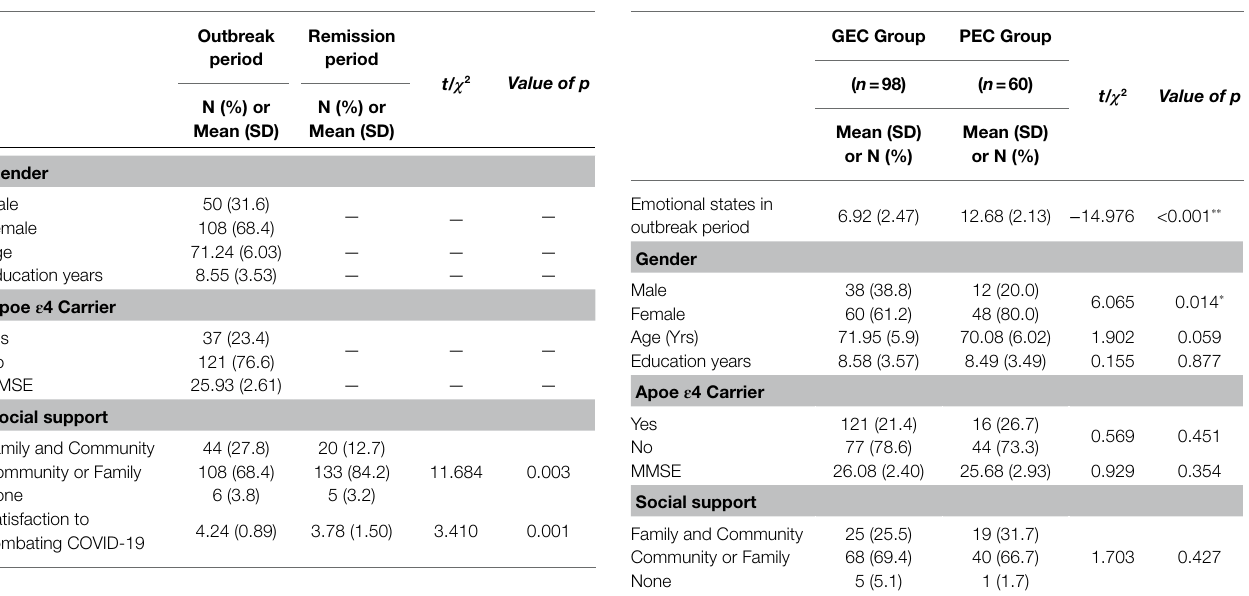
TABLE 4 | Participant characteristics of Good Emotional Coping (GEC) group and Poor Emotional Coping (PEC) group at the outbreak